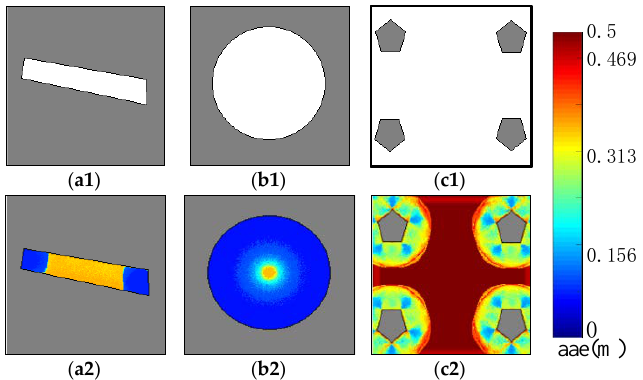
Figure 9. AGMs of virtual ambiguous environments: ( a1 – c1 ) are the occupancy grid maps of three artificial environments. ( a2 – c2 ) are the corresponding AGMs. AGMs show that the middle area of ( a1 ), the center area of ( b1 ) and the open area of ( c1 ) get high AAE value because of their ambiguous.